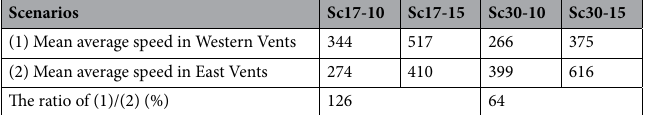
Table 5. The comparison of average speed in western vents (WVs) to eastern vents (EVs).